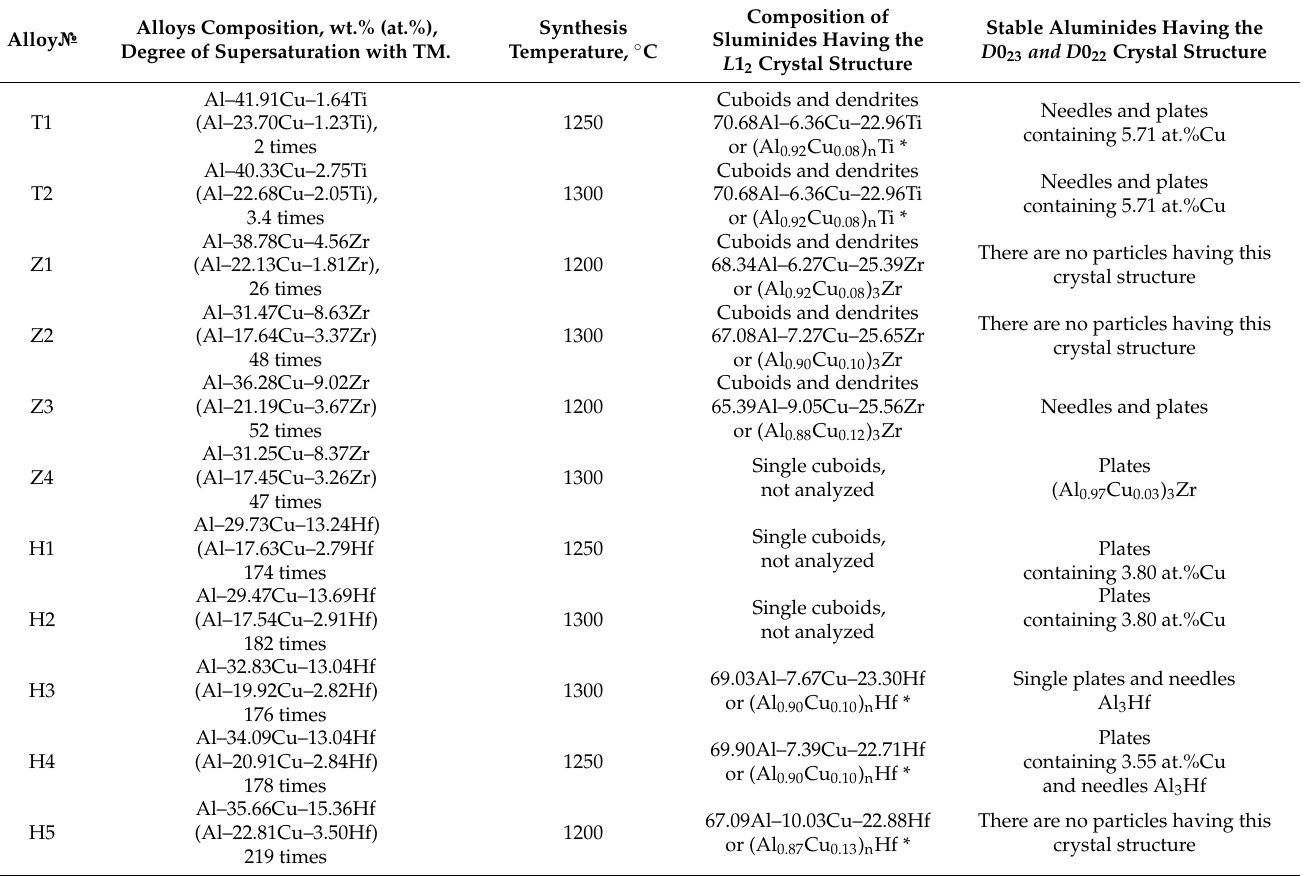
Table 1. Compositions of Al–Cu–X (X=Ti, Zr, Hf) alloys and the L 1 2 aluminides formed in